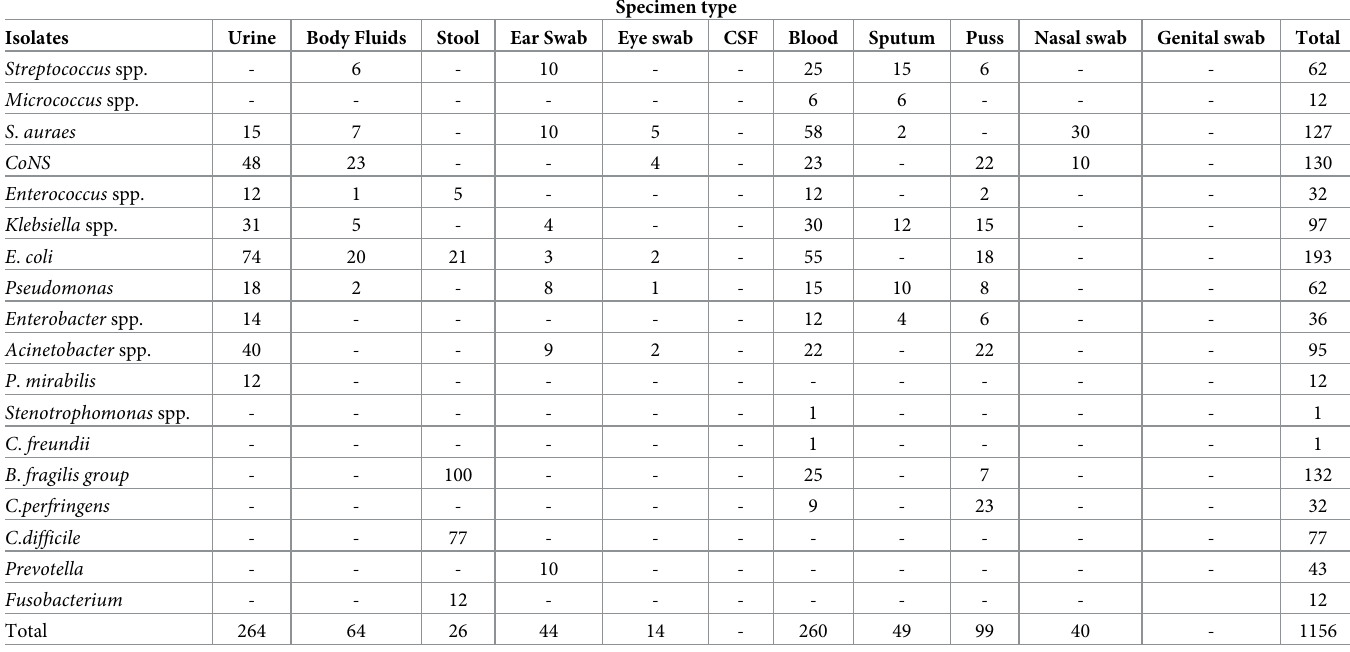
Table 2. Distribution of sample type and bacterial isolates from a study of the burden of antimicrobial resistance at Imam Khomeini Hospital